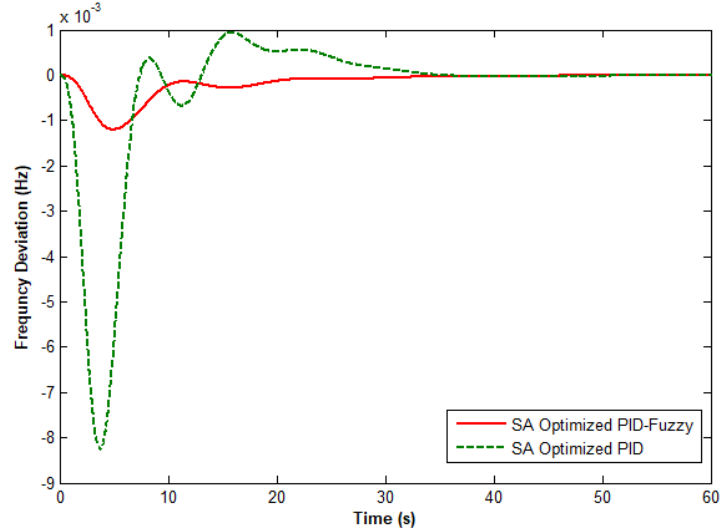
Figure 8. Frequency deviations in area 2 for the first case.